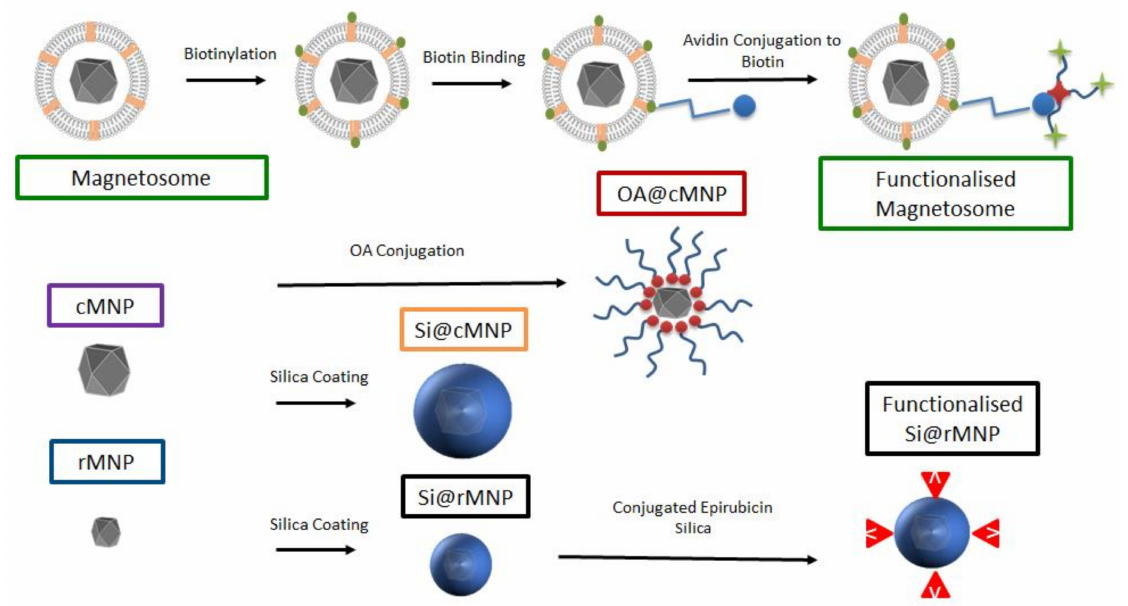
Figure 1. A schematic of the experimental design and samples produced in the study. Top labelled in green depicts the magnetosome and how it is biotinylated for functionalization. Centre left shows the control cMNP labelled in purple with surface coatings of oleic acid (red) and silica (orange label). Bottom left shows smaller control rMNP (blue label) coated with silica (black label) and with conjugated epirubincin (bottom right). Sample color-code used throughout in